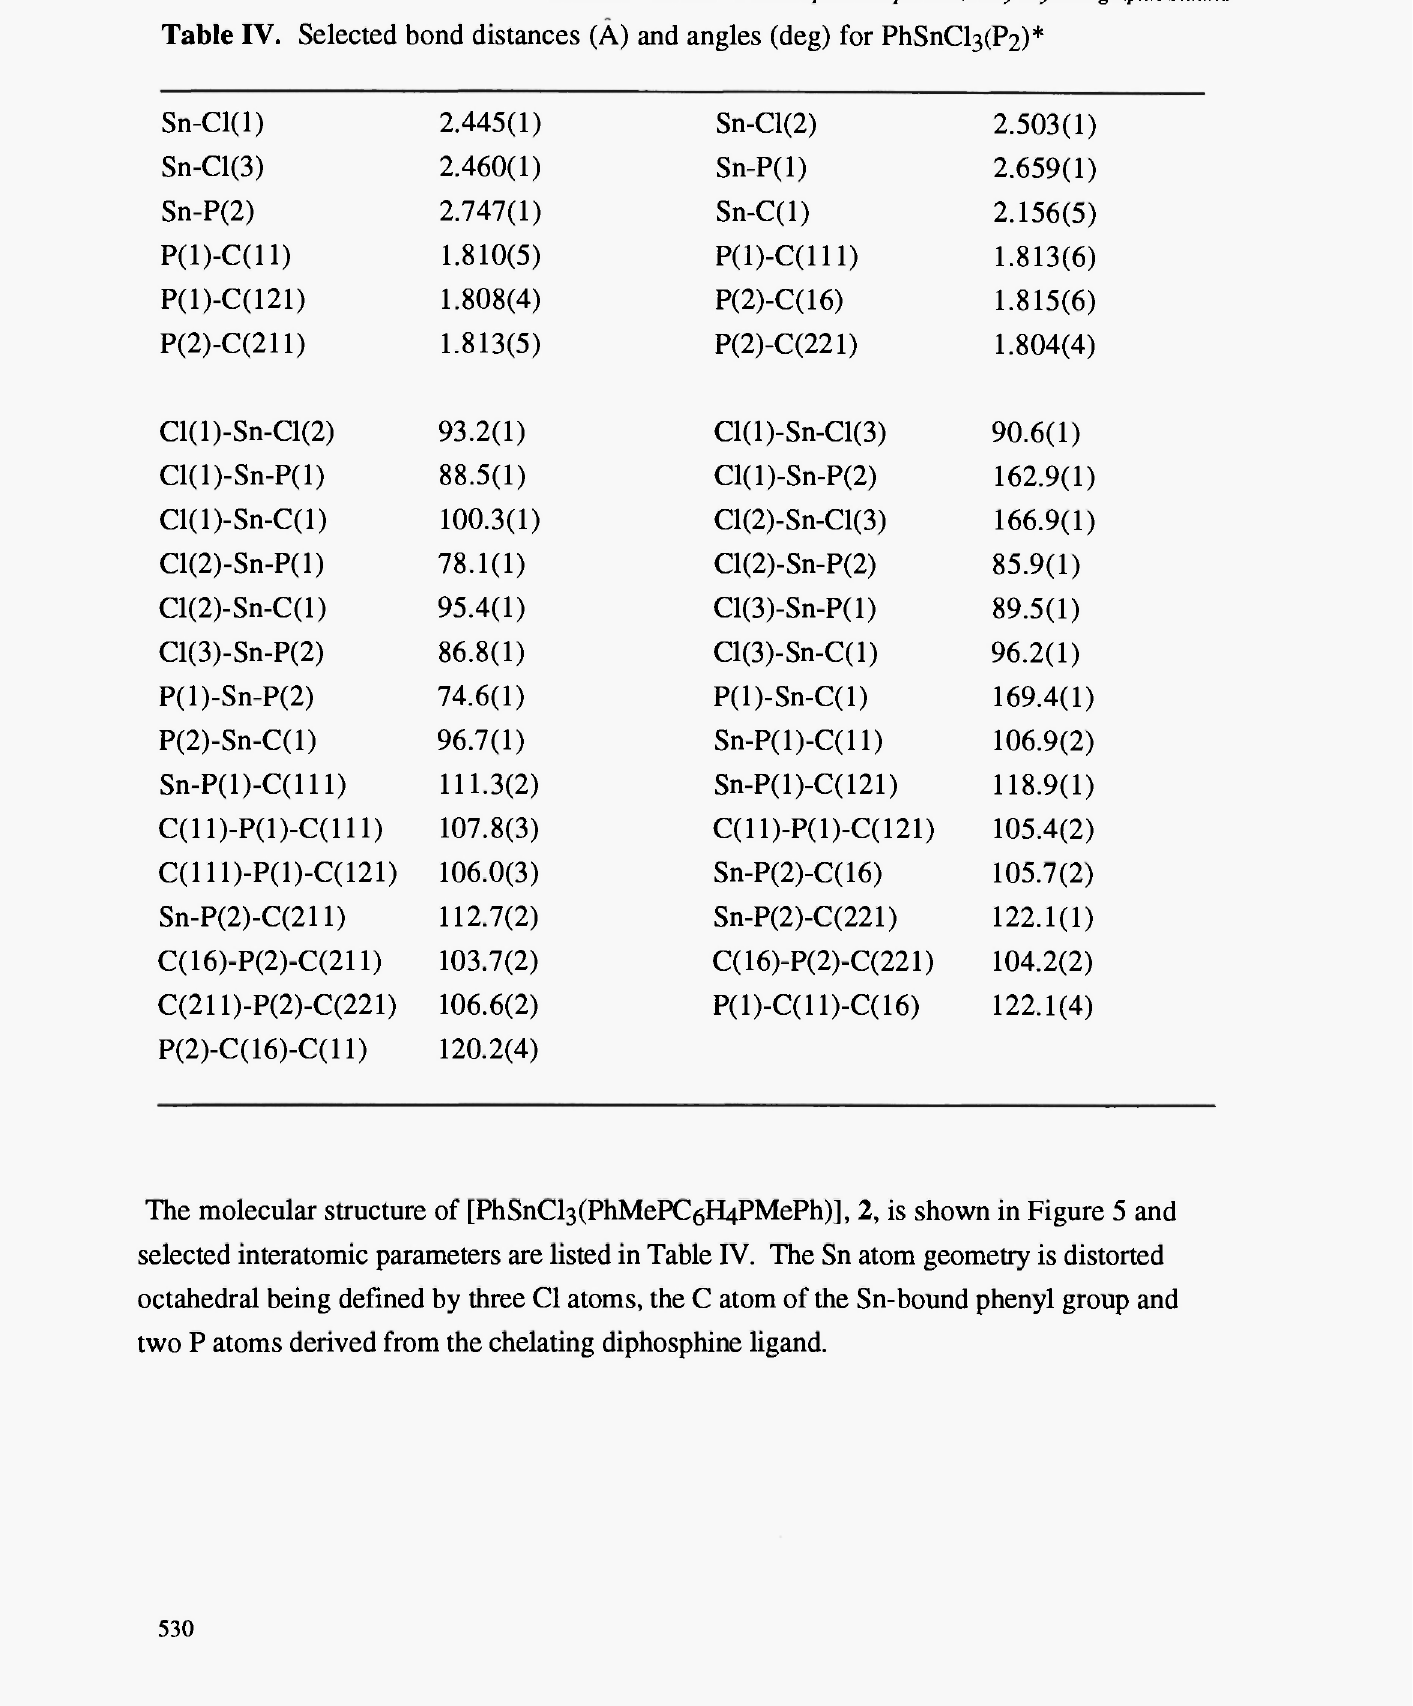
Table IV. Selected bond distances (A) and angles (deg) for